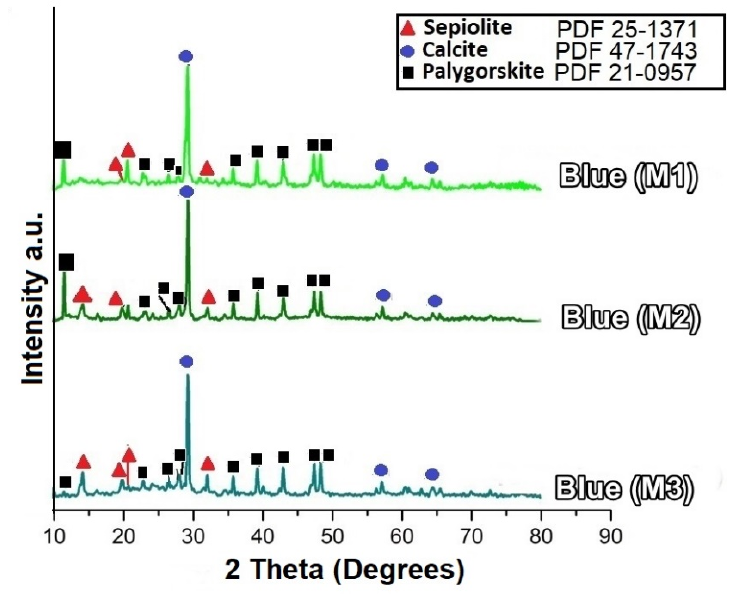
Figure 7. X-ray diffractogram of the blue pigment. The X-ray diffractograms of two samples with the red pigment are presented in Figure 8. It was possible to identify several crystalline phases: CaCO 3 , SiO 2 , Fe 2 O 3 , and PbO 2 ; the corresponding diffraction peaks for each phase were indicated in each diffractogram (Figure 8). According to the International Center for Diffraction Data (ICDD), the PDF card No. 02-0919 was identified for hematite, card No. 01-0649 for quartz, card No. 47-1743 for calcite, and card No. 41-1492 for lead dioxide. All the samples displayed some characteristic peaks at 23.05 ◦ , 29.40 ◦ , 35.97 ◦ , 43.16 ◦ , 47.11 ◦ , 56.56 ◦ , 60.99 ◦ , 64.66 ◦ , and 77.16 ◦ in the 2-theta scale that are associated with the hkl planes (012), (104), (202), (024), (202), (208), (300), (12-1), and (11-2) of calcite. The diffraction peaks at 25.42 ◦ , 31.97 ◦ , 40.66 ◦ , 52.12 ◦ , 58.89 ◦ , 66.83 ◦ , and 76.87 ◦ belonged to the hkl planes (101), (210), (220), (310), (202), and (400) related to lead dioxide, and the characteristic peaks at 24.23 ◦ , 33.28 ◦ , 35.74 ◦ , 40.99 ◦ , 49.49 ◦ , 54.23 ◦ , 57.55 ◦ , 62.72 ◦ , 75.374 ◦ , and 77.55 ◦ , which correspond to the hkl planes (110), (113), (024), (023), (116), (122), (214), (217), and (306), are linked to hematite. In Figure 8, the corresponding indexing planes for the identified crystalline phases are shown.